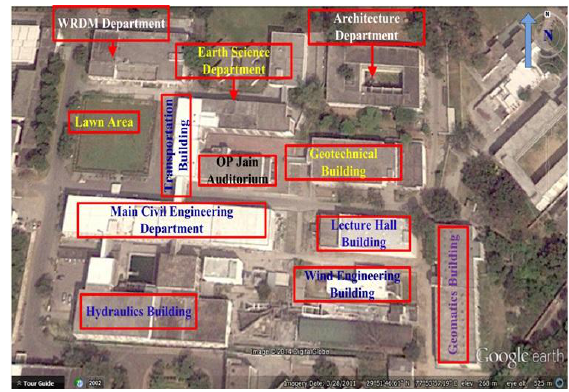
Figure 1: Civil Engineering Department (CED), IIT- Roorkee (Source: Google Earth, January 2014) 3. GENERAL OVERVIEW: COMPARISON OF THE IMAGE BASED 3 CITY MODELING